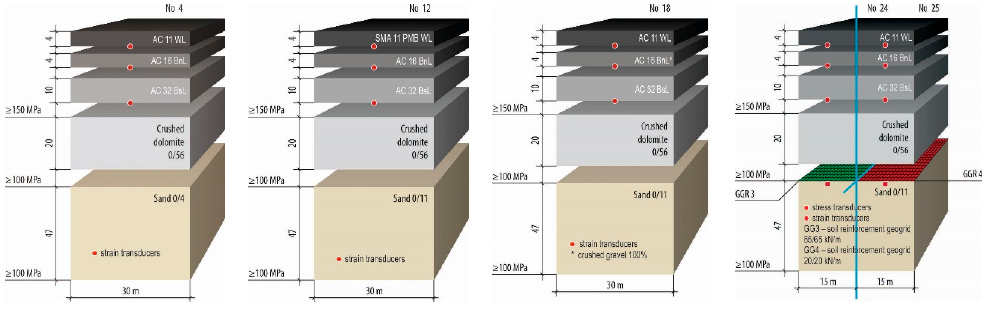
Figure 1. PSs of the Test Road: No 4, No 12, No 18 and No 24–25. Table 1. Positions of temperature and moisture content sensors in road pavement structures